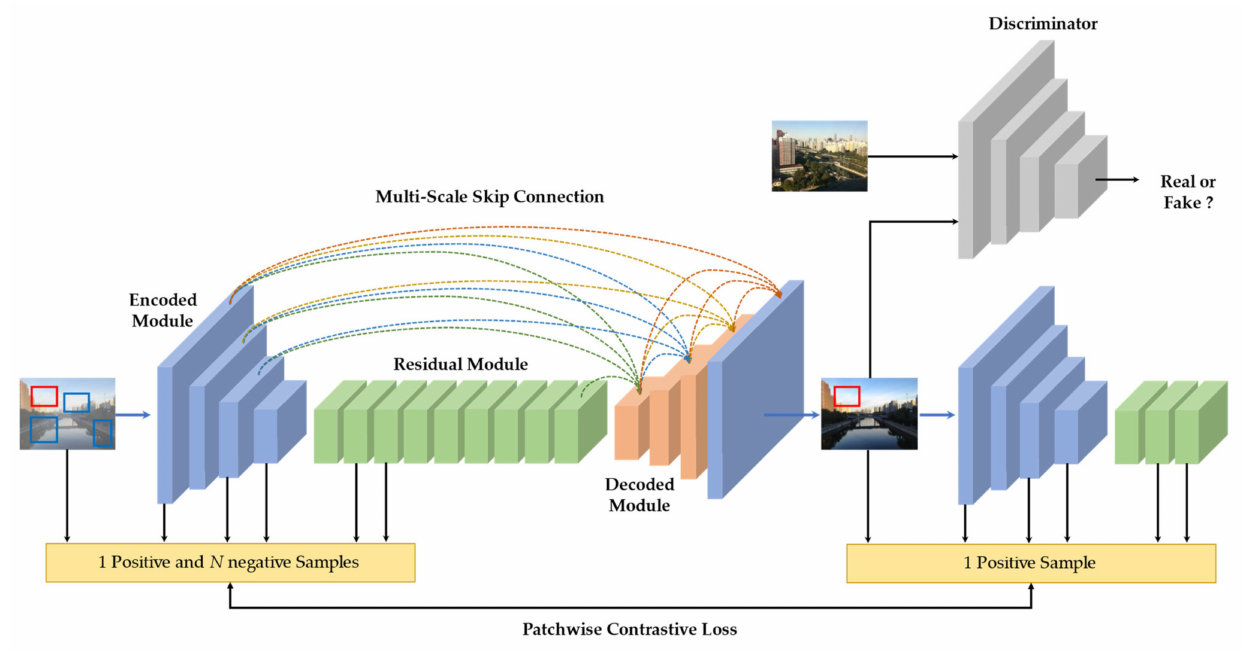
Figure 1. Framework structure of the proposed method. The red boxed area in the bottom-right image indicates the query sample, while the red boxed area in the bottom-left image indicates the positive sample, and the remaining blue boxes indicate negative